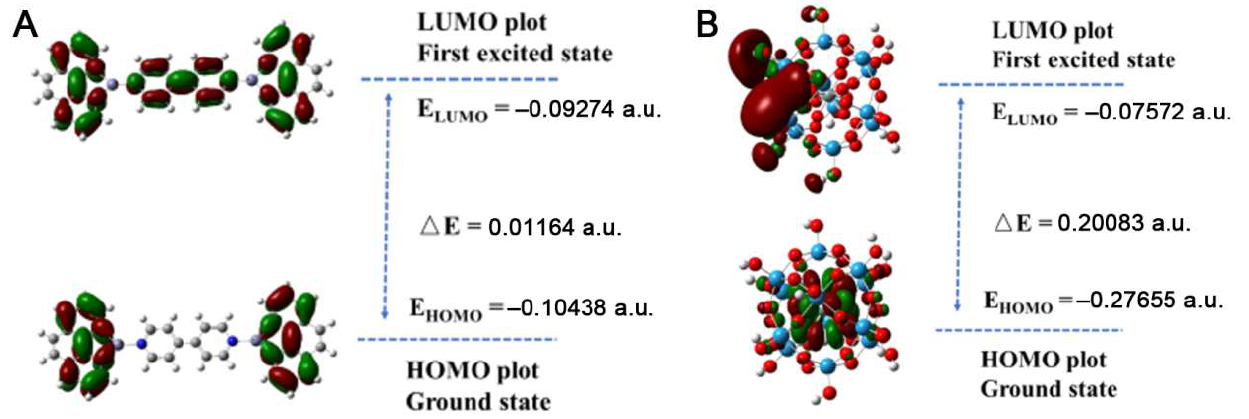
Figure 6. The selected surfaces of the molecular orbital plots (HOMO and LUMO) of [Zn 2 (4,4′- bpy)(Phen) 2 ] 4+ ( A ) and [SiW 12 O 40 ] 4– cluster ( B ).